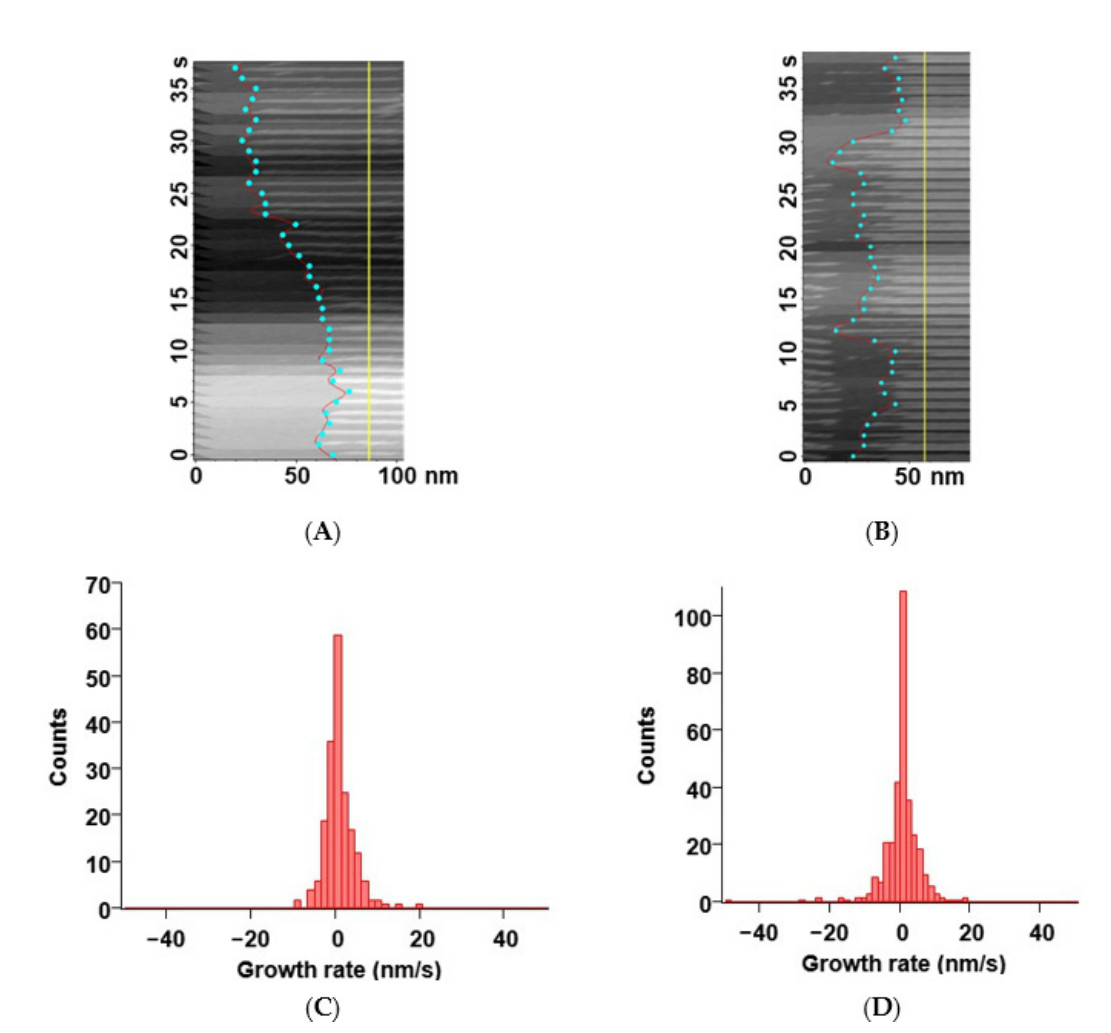
Figure 4. Growth and dissociation rates of FtsZt filaments: ( A , B ) Typical kymographs of a single FtsZt filament in the growth condition ( A ) and the dissociation condition ( B ). Cyan circles represent the position of filament ends on each frame. Yellow line shows the base line for the measurement of length. The time axis goes from the bottom to the top; ( C , D ) Histograms of growth/dissociation rates of FtsZt filaments in the growth condition ( C ) and the dissociation condition ( D ). Scale bars: 50–100 nm.